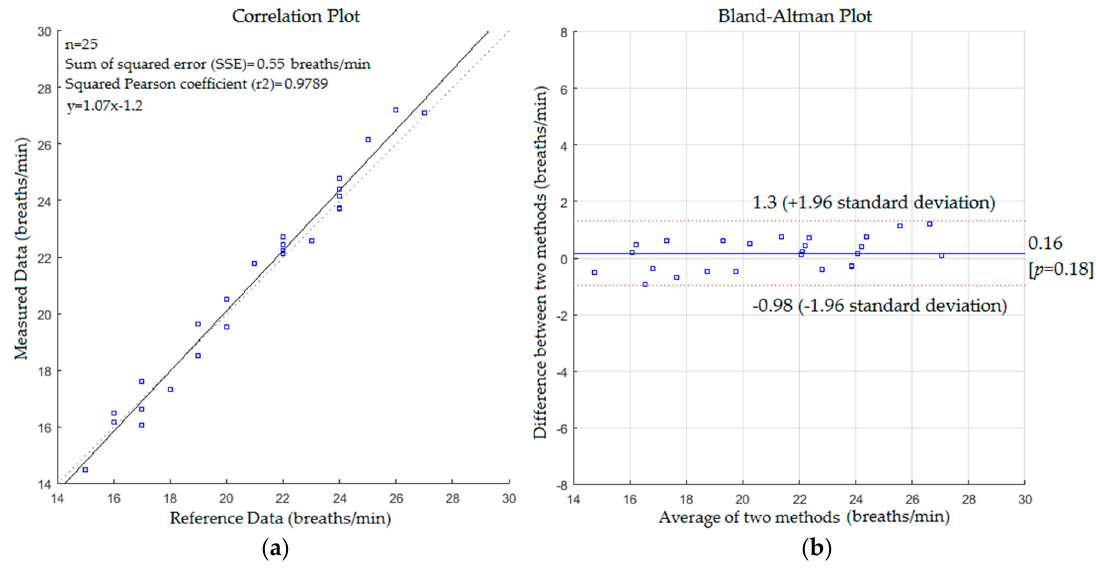
Figure 11. ( a ) Correlation plot; ( b ) Bland-Altman plot of the difference between measured data and reference data (second scenario without a blanket).